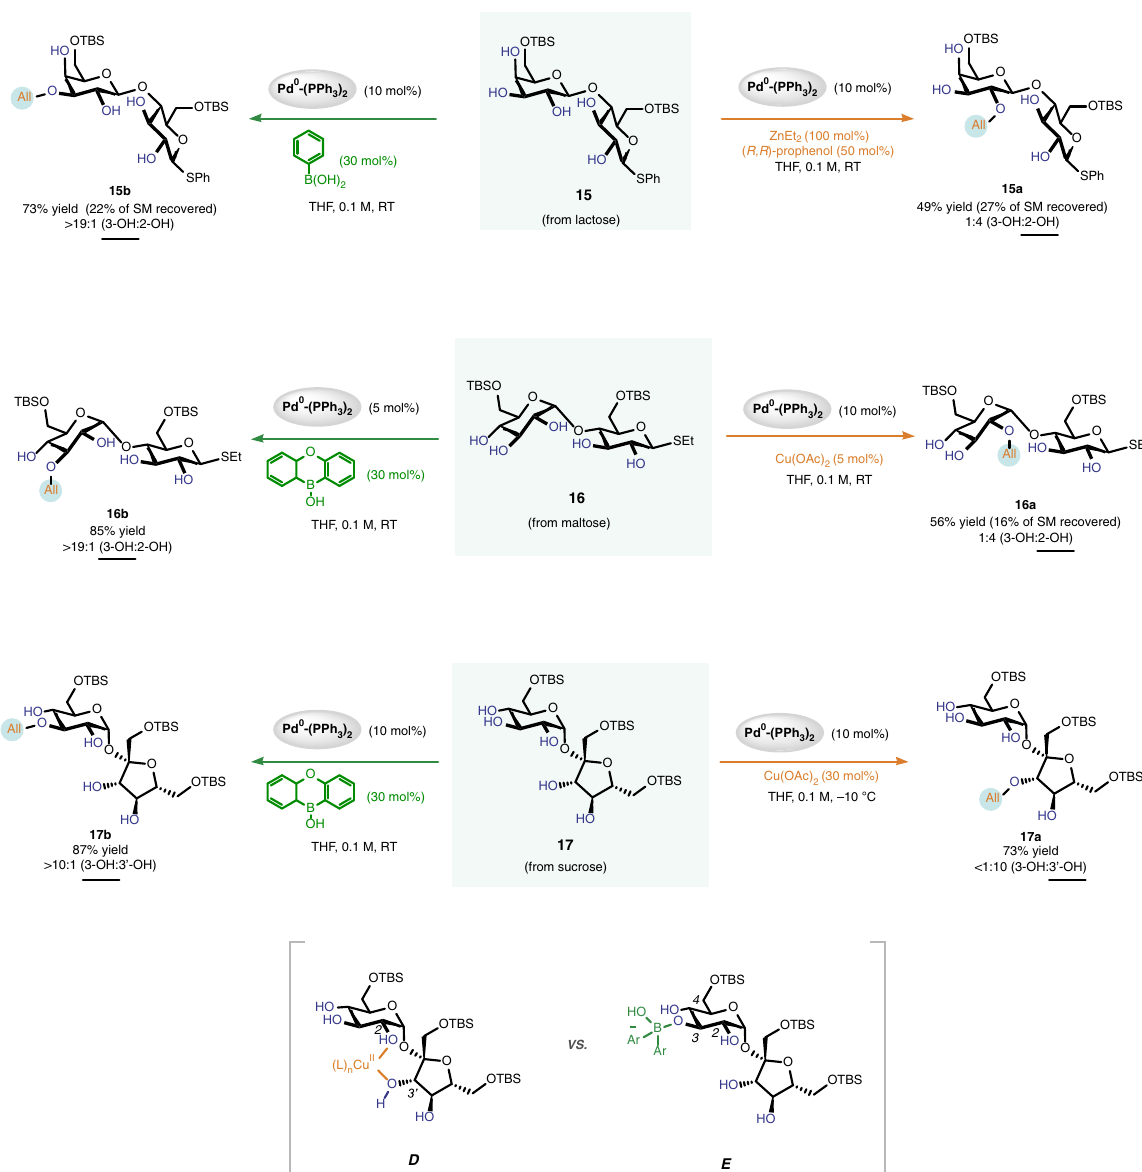
Fig. 4 Site-switchable mono- O -allylation of disaccharides. Product ratios were determined by 1 H NMR analysis of reaction mixtures. Reported yields are isolated yields of products that are underlined. See Supplementary Information for experimental